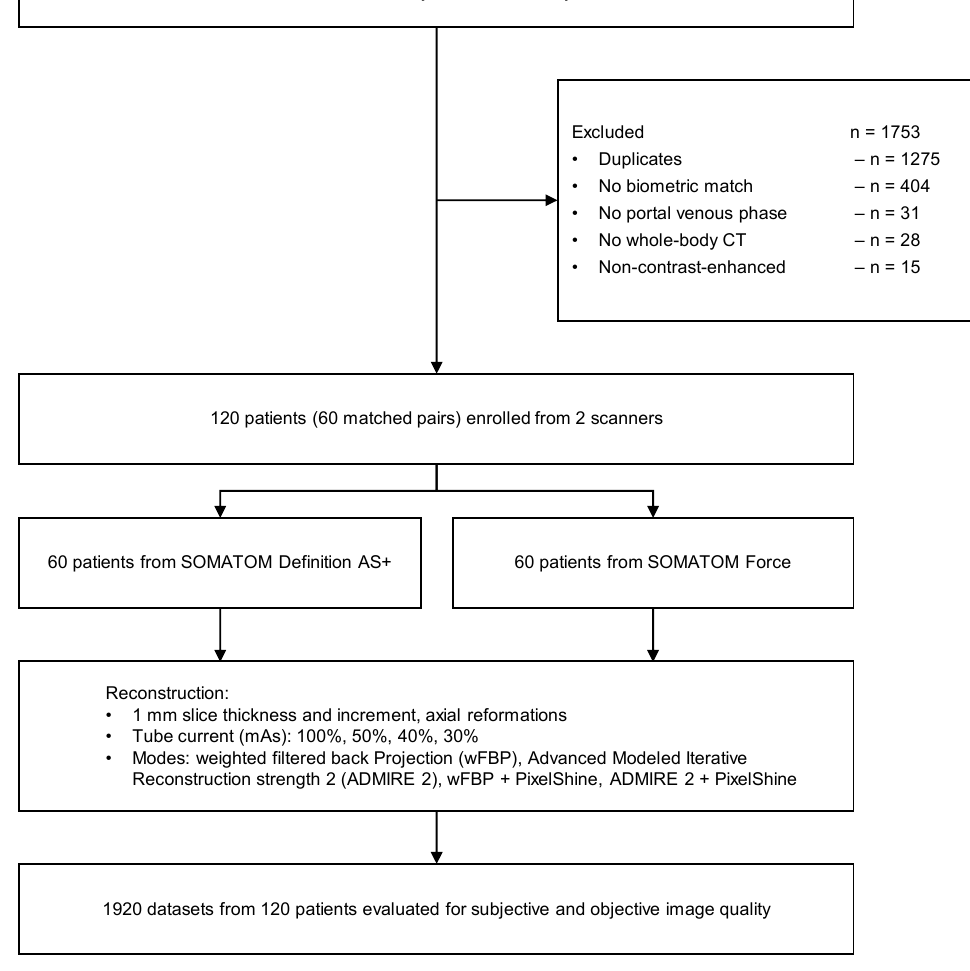
Figure 1. Study flowchart and patient enrollment. wFBP = weighted filtered back-projection; ADMIRE 2 = Advanced Modeled Iterative Reconstruction strength 2.